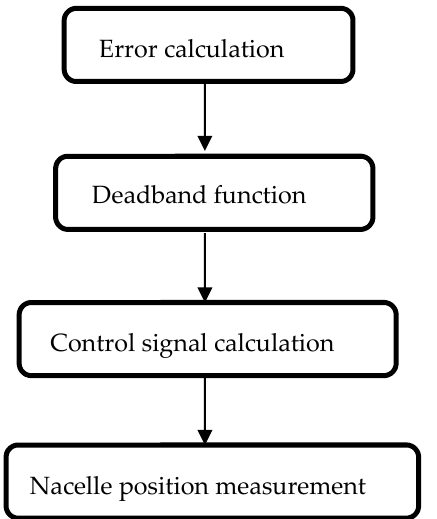
Figure 6. Pipeline of the operating principle of the conventional wind turbine yaw control of the I regulator.